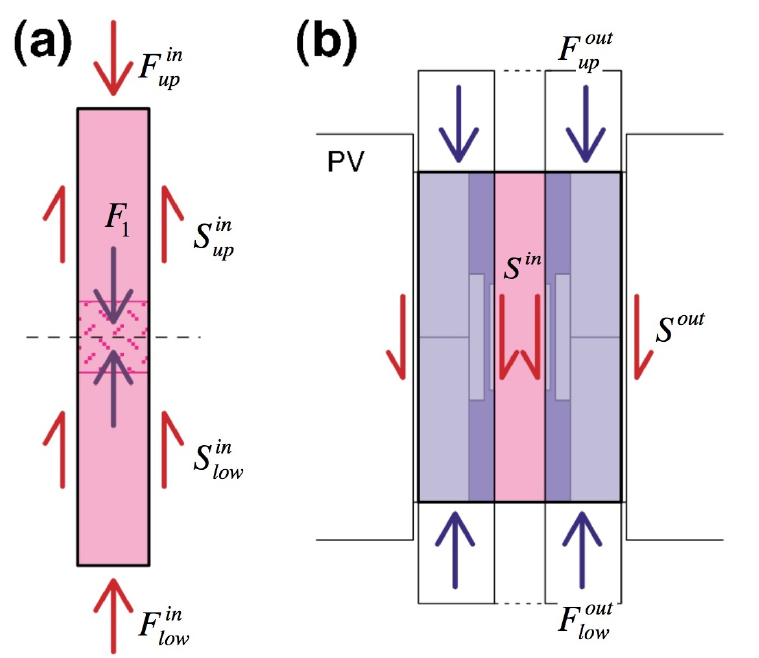
Figure 5. Force balance in the solid medium assembly. The forces acting on the cylinder core ( a ) and confining medium ( b ) are indicated by red and blue arrows. PV: pressure vessel. See text for